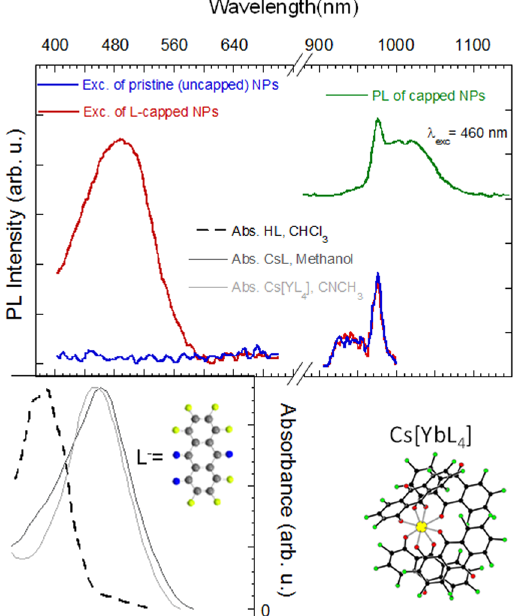
Figure 2. Green curve: NIR emission spectrum of 2-hydroxy-perfluoroanthraquinone-capped 10% Yb 3 + - doped NaYF 4 nanoparticle at 460 nm excitation. Blue, red curves, resp.: excitation spectra of pristine (only Oleic-Ac/Oleyl-Am-solubilized) and functionalized (chromophore/nanoparticle suspension concentration ratio of 0.44) 10% Yb 3 + -doped NaYF 4 nanoparticles for the 1030 nm emission. The spectra are normalized to the IR band. Dotted curve: absorption spectrum of the 2-hydroxy-perfluoroanthraquinone (LH) solution (chloroform). Gray curves: absorption of the CsL solution (methanol) and Cs[YbL 4 ] complex (acetonitrile). All spectra are given on the same wavelength scale. The structure of the ligand and complex is schematically represented.